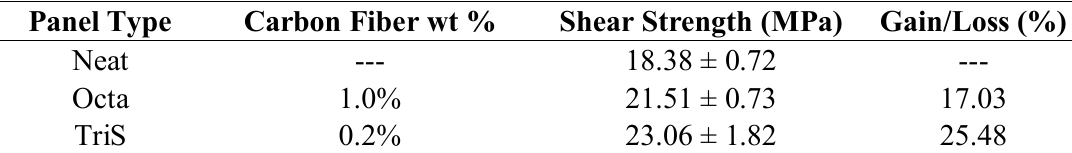
Table 1. Comparison of interlaminar shear